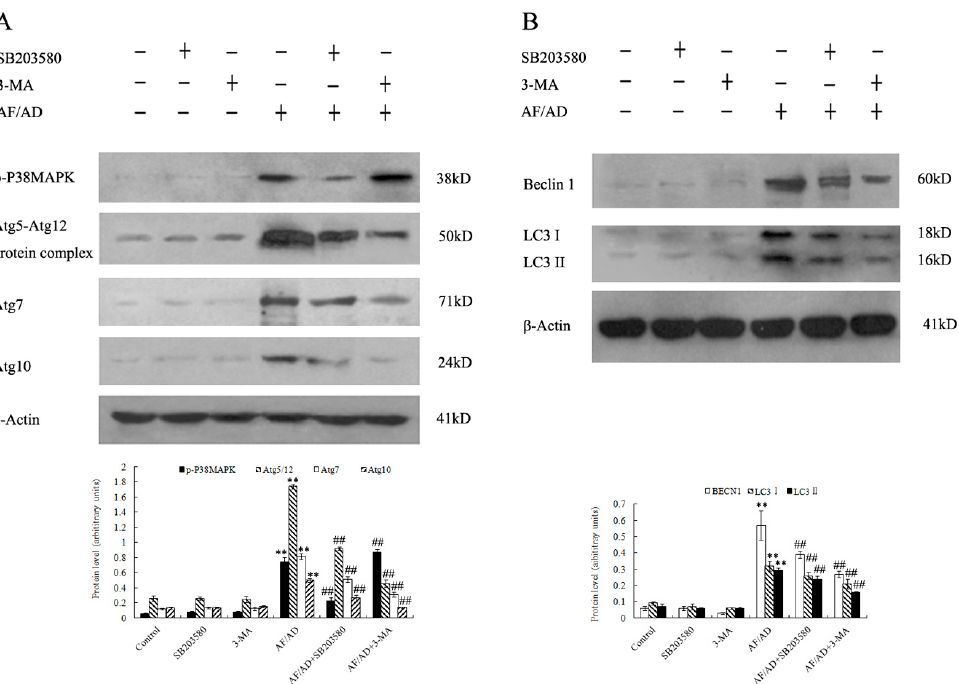
Figure 3. Effect of AF/AD on p-P38MAPK, Atg5-Atg12 protein complex, Atg7, Atg10, Beclin-1, LC3 I, and LC3 II, respectively, with or without SB203580 or 3-MA in Bel-7402 cells analyzed by immunoblot assay. Bel-7402 cells were pretreated with AF (6 μ M)/AD (20 μ M) in the absence or presence of SB203580 (10 μ M) or 3-MA (5 mM) for 24 h. Expression of p-P38MAPK, Atg5-Atg12 protein complex, Atg7, and Atg10 ( A ), and expression of Beclin-1 and LC3 ( B ) were analyzed by immunoblot assay. Values presented are representative of three independent experiments (means ± S.D.; ** p < 0.01, compared with control treatment; ## p < 0.01, compared with AF/AD treatment).